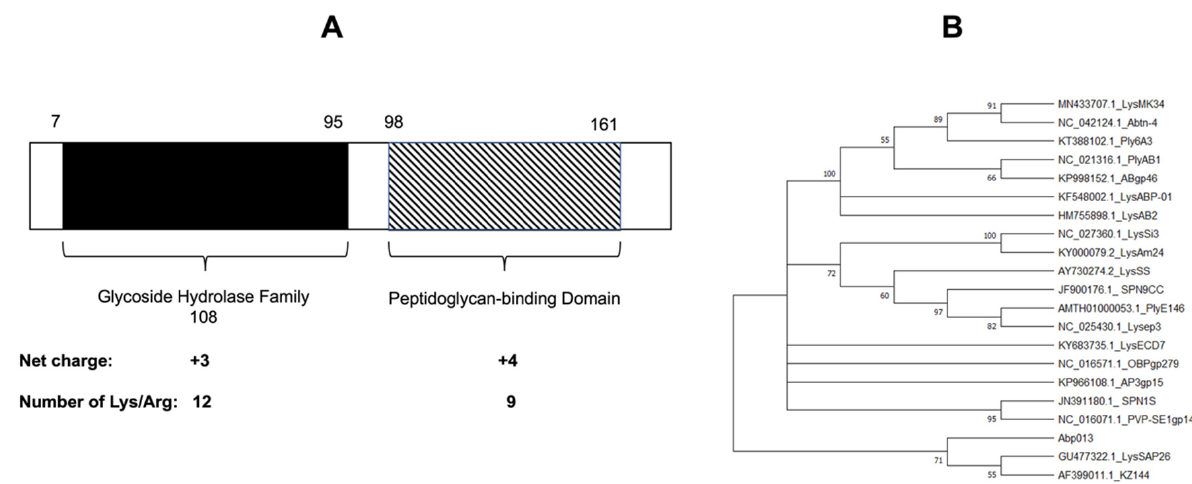
Figure 1. Bioinformatic analysis of Abp013. ( A ) Schematic diagram of the domain organization of Abp013. The glycoside hydrolase family 108 (net charge: +2) is located between amino acid residues 7 and 95, while the peptidoglycan-binding domain (net charge: +3) is located between residues 98 and 161. ( B ) Bootstrap consensus tree showing the phylogenetic relationship of Abp013 and previously reported Gram-negative lysins. The nucleotide sequences were aligned via ClustalW, and the evolutionary history was inferred via the Neighbor–Joining tree method using MEGA11 software.